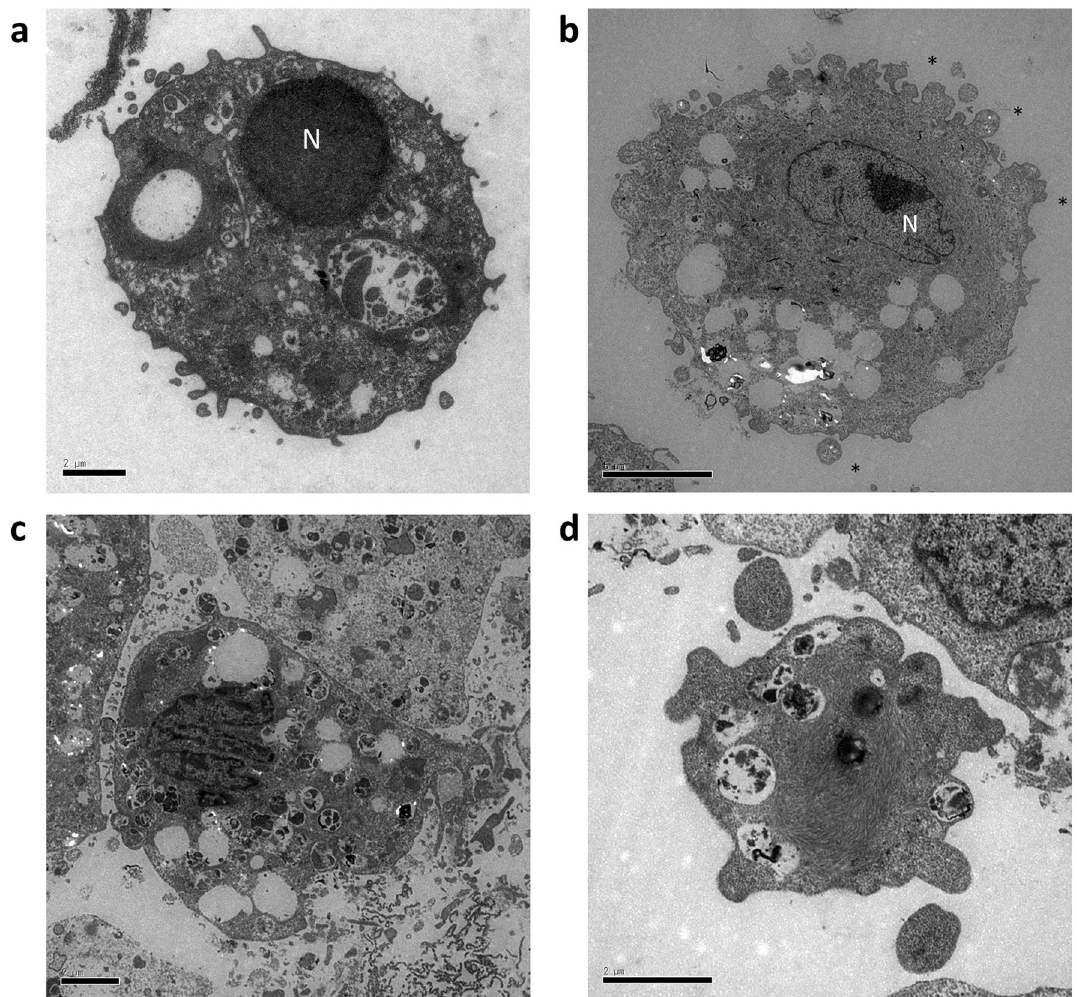
Figure 3 . Transmission electron microscopy (TEM) appearance of HHP-treated fibroblast cells. ( a ) Untreated cells (0 MPa) exhibited a normal morphology with intact membrane, scant cytoplasm and round nuclei (N). ( b ) Cells subjected to HHP 50 MPa for 36 h showed early apoptosis with chromatin condensation, black structures along the nuclear membrane and membrane blebbing (*); ( c ) late apoptosis with nuclear fragments of formed apoptotic bodies and many intracellular vacuoles; and ( d ) the release of apoptotic bodies at the final stage of apoptosis. Magnification 8000×, scale bar: 2